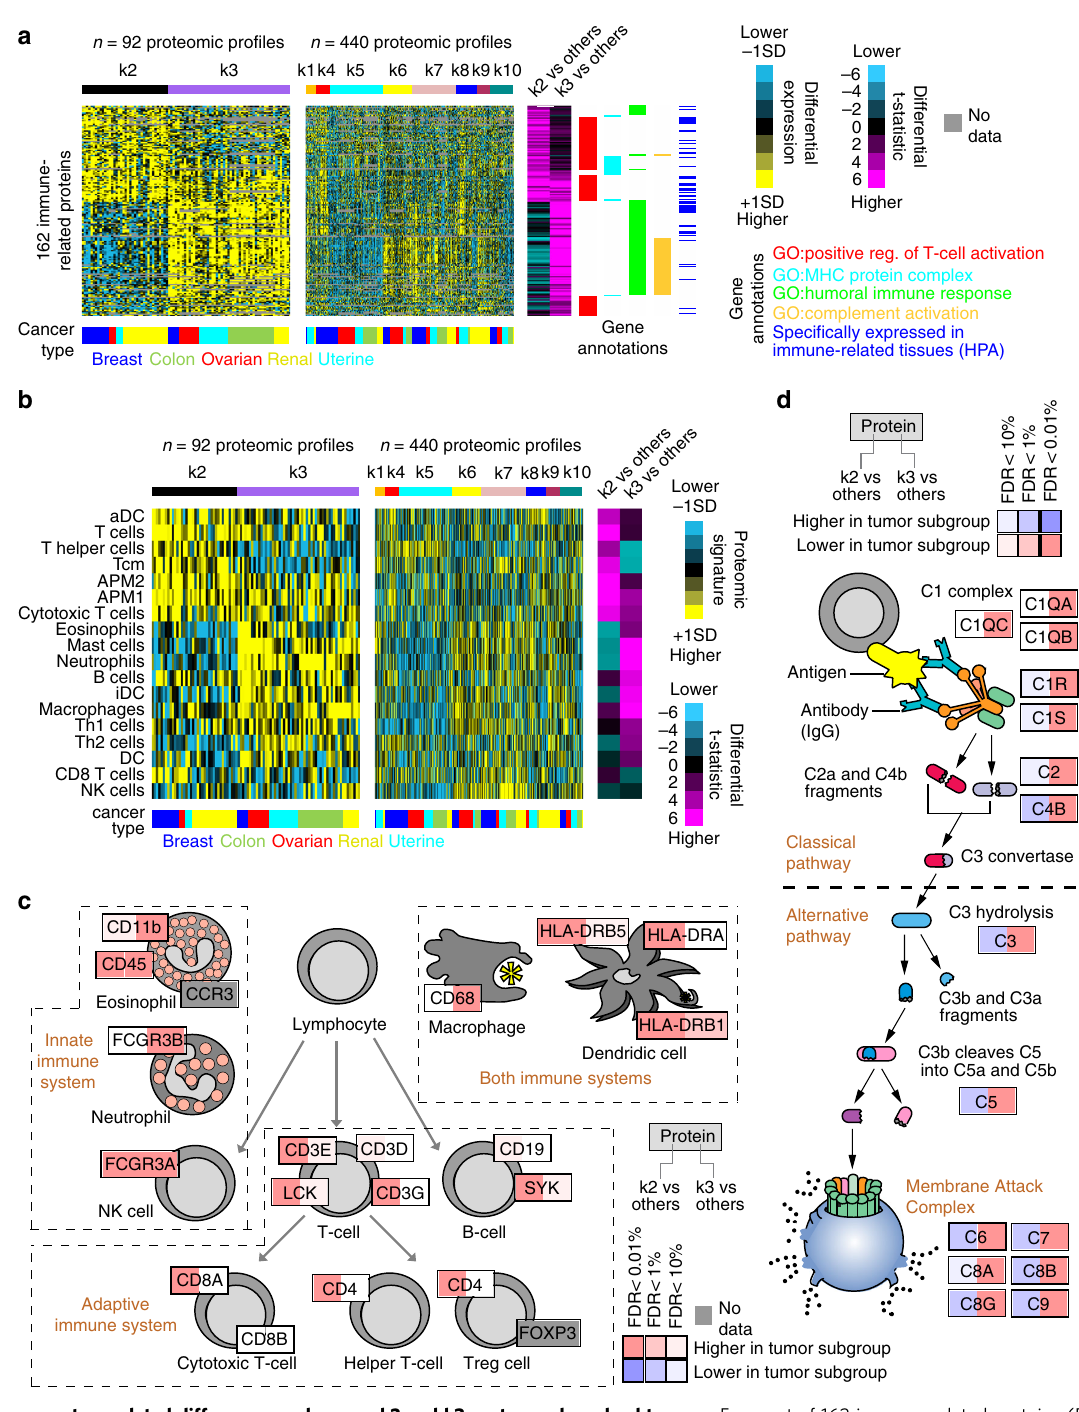
Fig. 5 Immune system-related differences underscore k2 and k3 proteome-based subtypes. a For a set of 162 immune-related proteins (FDR < 5% for either k2 or k3 subtypes and association with one of the indicated GO annotation categories), heat maps of differential protein expression patterns (expression values normalized within cancer type; SD, standard deviation from the median), across CPTAC Con fi rmatory/Discovery proteomic pro fi les, ordered by subtype. Purple-cyan heat map denotes t -statistics for comparing the given subtype versus the other tumors (bright purple/cyan, highly signi fi cant; black, not signi fi cant; shades close to black, borderline signi fi cant). Proteins found speci fi cally expressed in immune-related tissues (according to Human Protein Atlas 14 , or HPA, www.proteinatlas.org) are indicated. b Heat maps of gene expression-based signatures 15 of immune cell in fi ltrates, across CPTAC Con fi rmatory/Discovery proteomic pro fi les, ordered by subtype (expression values normalized within cancer type; SD, standard deviation from the median). Purple-cyan heat map denotes t -statistics for comparing the given subtype versus the other tumors. APM1/APM2, antigen presentation on MHC class I/class II, respectively; DC dendritic cells; iDC immature DCs; aDC activated DCs; NK cells natural killer cells; Tcm cells T central memory cells; Tem cells T effector memory cells. c Diagram of immune cell types and associated protein markers. Red denotes signi fi cantly higher expression in k2 or k3 subtypes as indicated, and blue denotes signi fi cantly lower expression. FDR false discovery rate. d Similar to part c , but for complement activation pathway. See also Supplementary Fig.